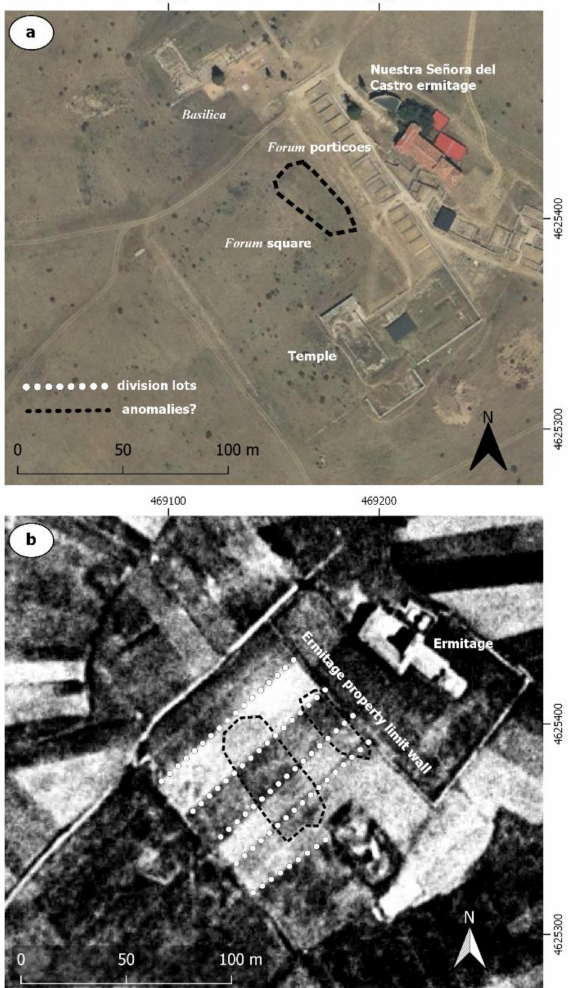
Figure 5. ( a ) Google satellite QuickMapServices. ( b ) USAF flight